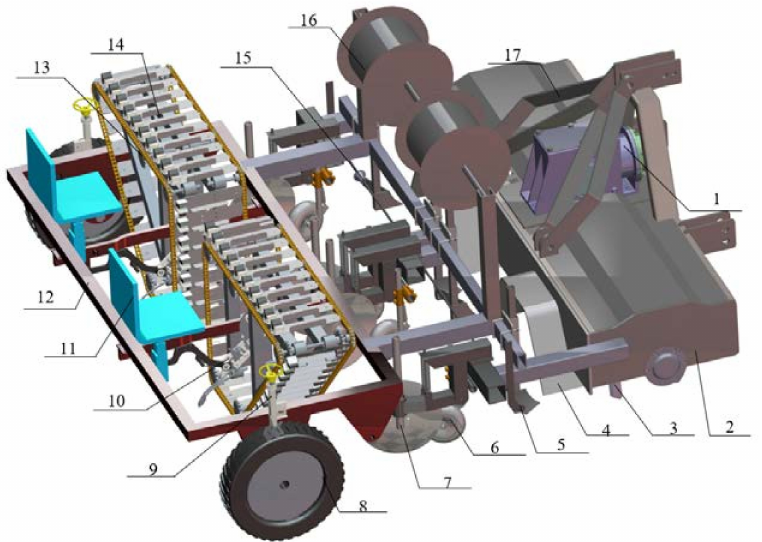
Figure 3. Structure of the 2CGFS-2 compound transplanter for sweet potato slip cultivation in the RBF and RB cultivation systems in northern China. Note: 1, Transmission box; 2, Lateral sealing plate; 3, Rotary component; 4, Ridging board; 5, Ridging opener; 6, Film pressing wheel; 7, Soil covering disc; 8, Driving wheel; 9, Height adjustment; 10, slip taking-planting mechanism; 11, Chair; 12, Frame; 13, Drive system; 14, Slip delivery mechanism; 15, Plastic-film frame; 16, Laying device of drip irrigation belt; 17, Three-point hitch